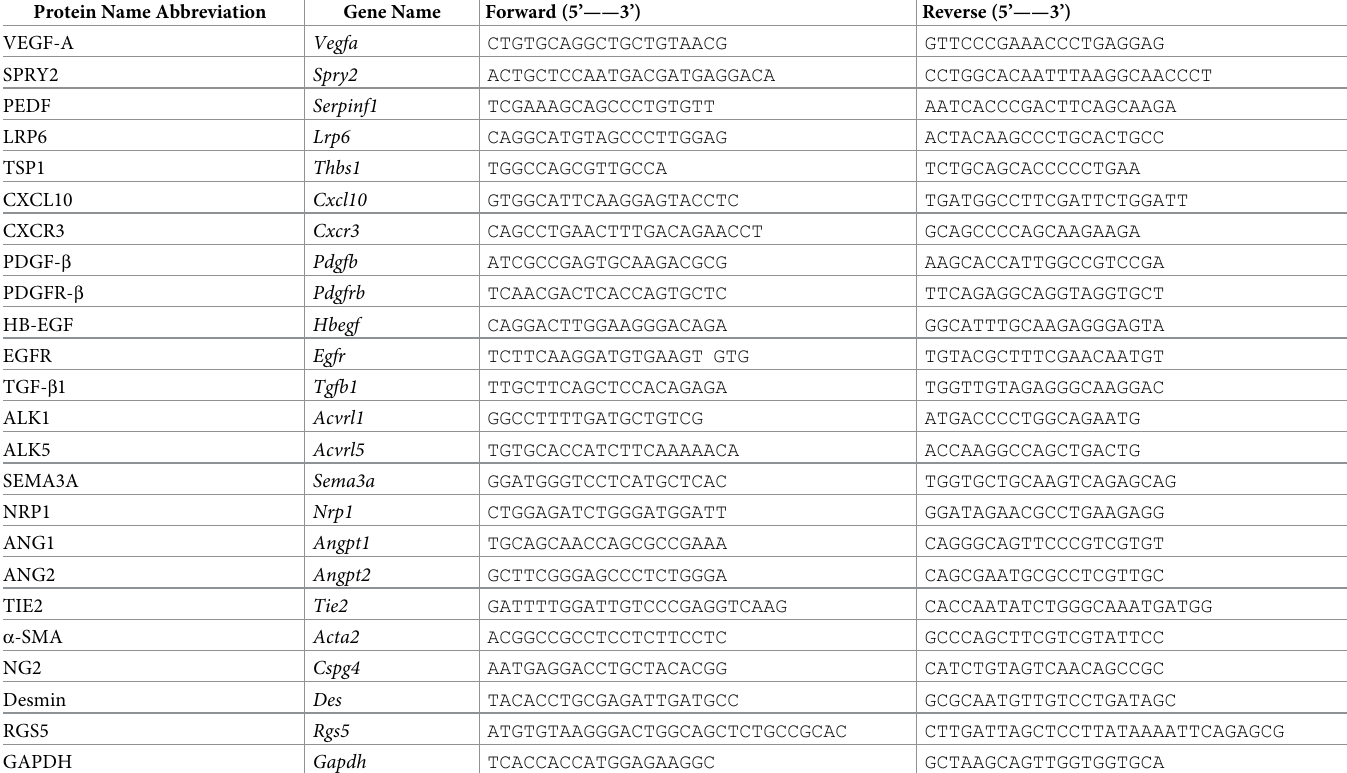
Table 1. Primer sequences for real time